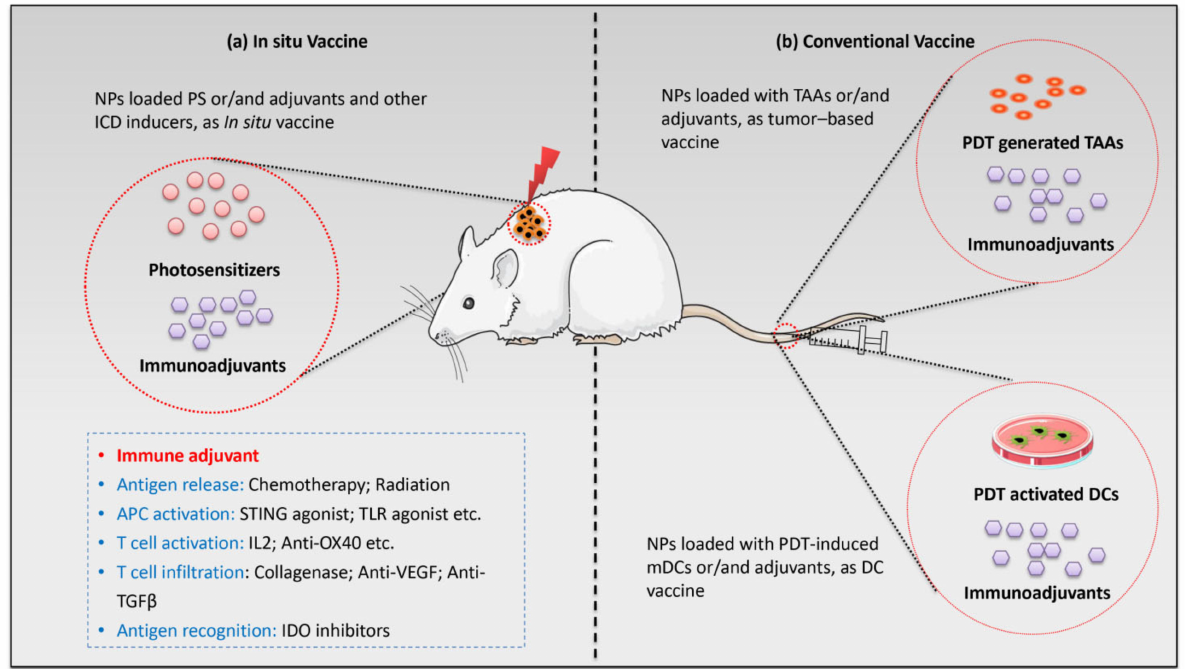
Figure 7. Nanoparticle-based PDT generated vaccines: ( a ) NPs carrying PS and/or immune adjuvants accumulate in tumor tissue after administration. Through irradiation, PDT itself will supply tumor antigens; ( b ) NPs carrying PDT-generated tumor antigens or ex vivo stimulated mature DCs (and/or together with immune adjuvant) are administered systemically as conventional vaccines. This activates and expands effector T cells for vaccine antigen-specific systemic responses. With the help of immune adjuvants and other ICD inducers, strong systemic antitumor immunity against all tumor antigens will be induced, and PDT treatment will ablate surviving tumor cells and metastatic